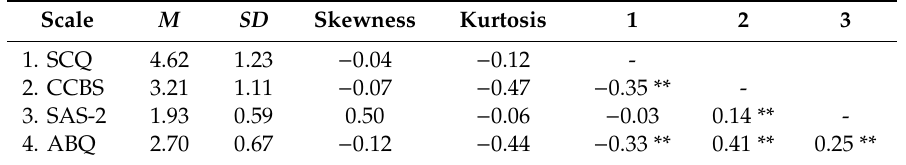
Table 2. Mean ( M ), standard deviation ( SD ), skewness, kurtosis, and correlations of scale composite